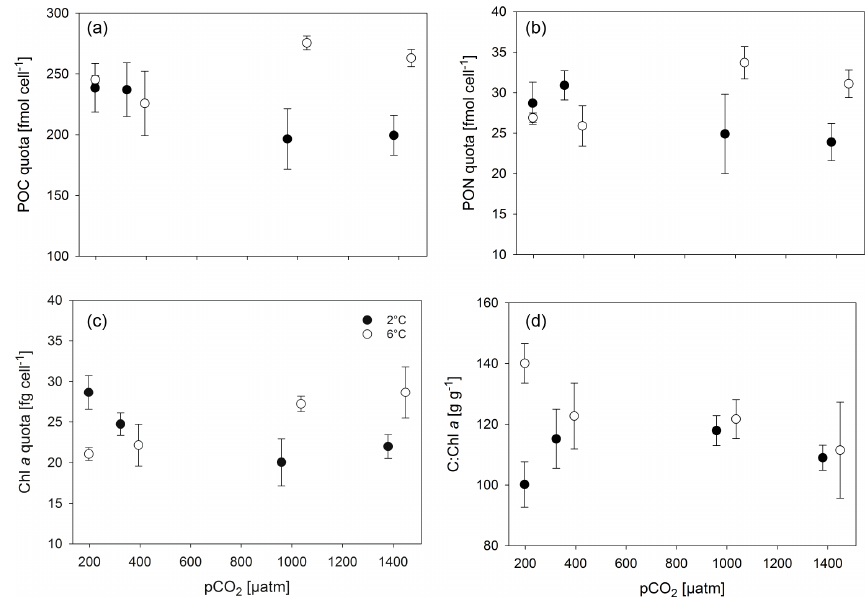
Figure 2. Cellular composition, i.e. POC (a) , PON (b) and Chl a quota (c) as well as C : Chl a ratios (d) , of M. pusilla under low (filled symbols) and high (open symbols) temperatures as a function of p CO 2 ( n = 3; mean ± 1SD). Results from statistical analysis can be found in Table